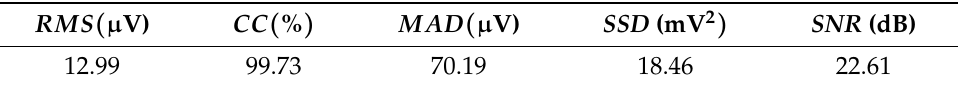
Table 2. Results obtained in the reconstruction showed in Figure 8 for the proposed location.